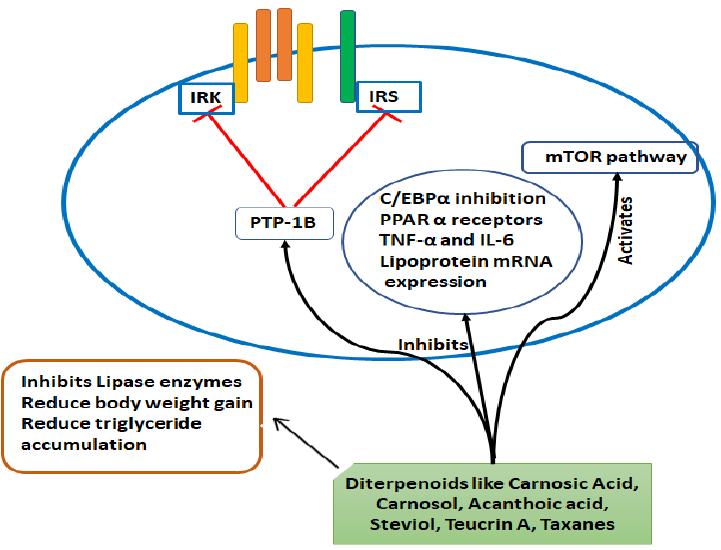
Figure 5. The anti-obesity mechanisms of diterpenoids.